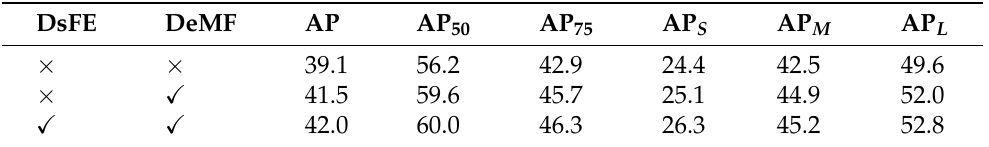
Table 5. The effect of components of the proposed Enhanced Positive Sample Filter on COCO val2017 set. ‘DsFE’ and ‘DeMF’ indicate using the Dual-stream Feature Enhancement and Disentangled Max Pooling Filter